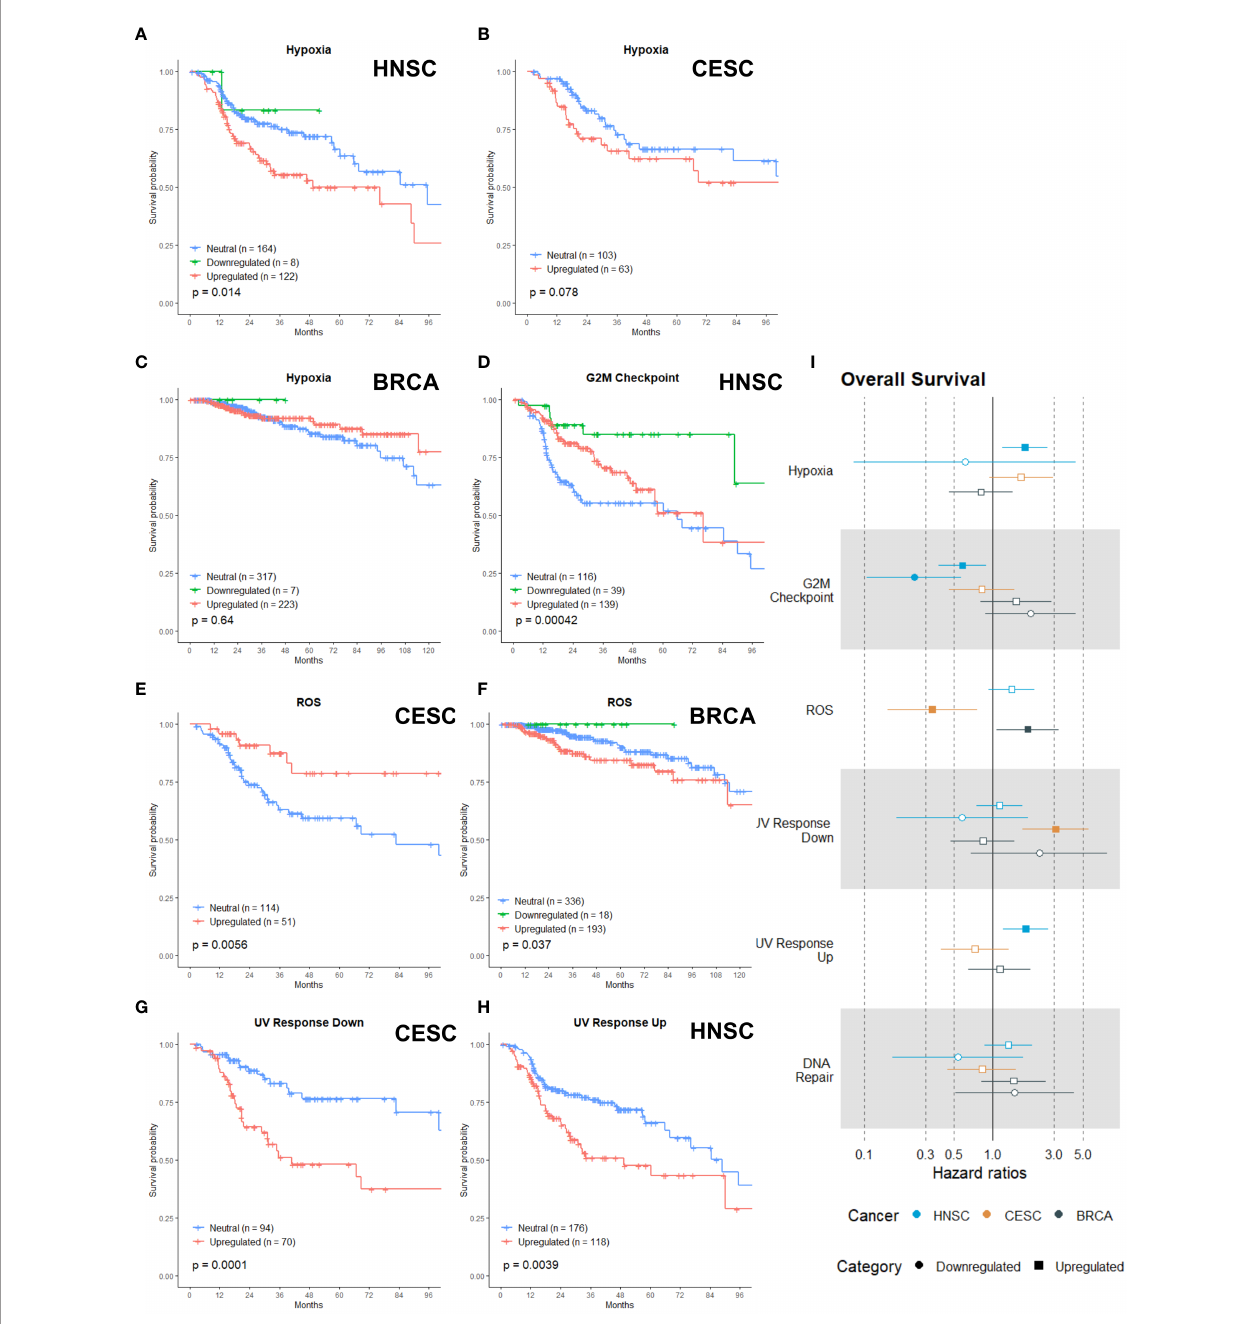
FIGURE 2 | Associations of gene sets of the Radiobiological category with patient overall survival times. Kaplan-Meier plots for the Hypoxia gene set of (A) HNSC, (B) CESC and (C) BRCA patients associated with OS. (D) Kaplan-Meier plot for the G2M Checkpoint gene set of HNSC patients associated with OS. Kaplan-Meier plots for the ROS gene set for (E) CESC and (F) BRCA patients associated with OS. (G) Kaplan-Meier plot for the UV Response Down gene set for CESC patients associated with OS. (H) Kaplan-Meier plot for the UV Response Up gene set for HNSC patients associated with OS. (I) Forest plot showing the results from CoxPH model fi ts for OS of all the Radiobiological category gene sets. Results for the HNSC patients are in blue, brown for the CSC patients and black for the BRCA patients. Upregulated gene sets are depicted with a □ symbol [closed ■ means these results are signi fi cant (p>0.05)]. Downregulated gene sets are depicted with a ○ symbol [closed ● means these results are signi fi cant